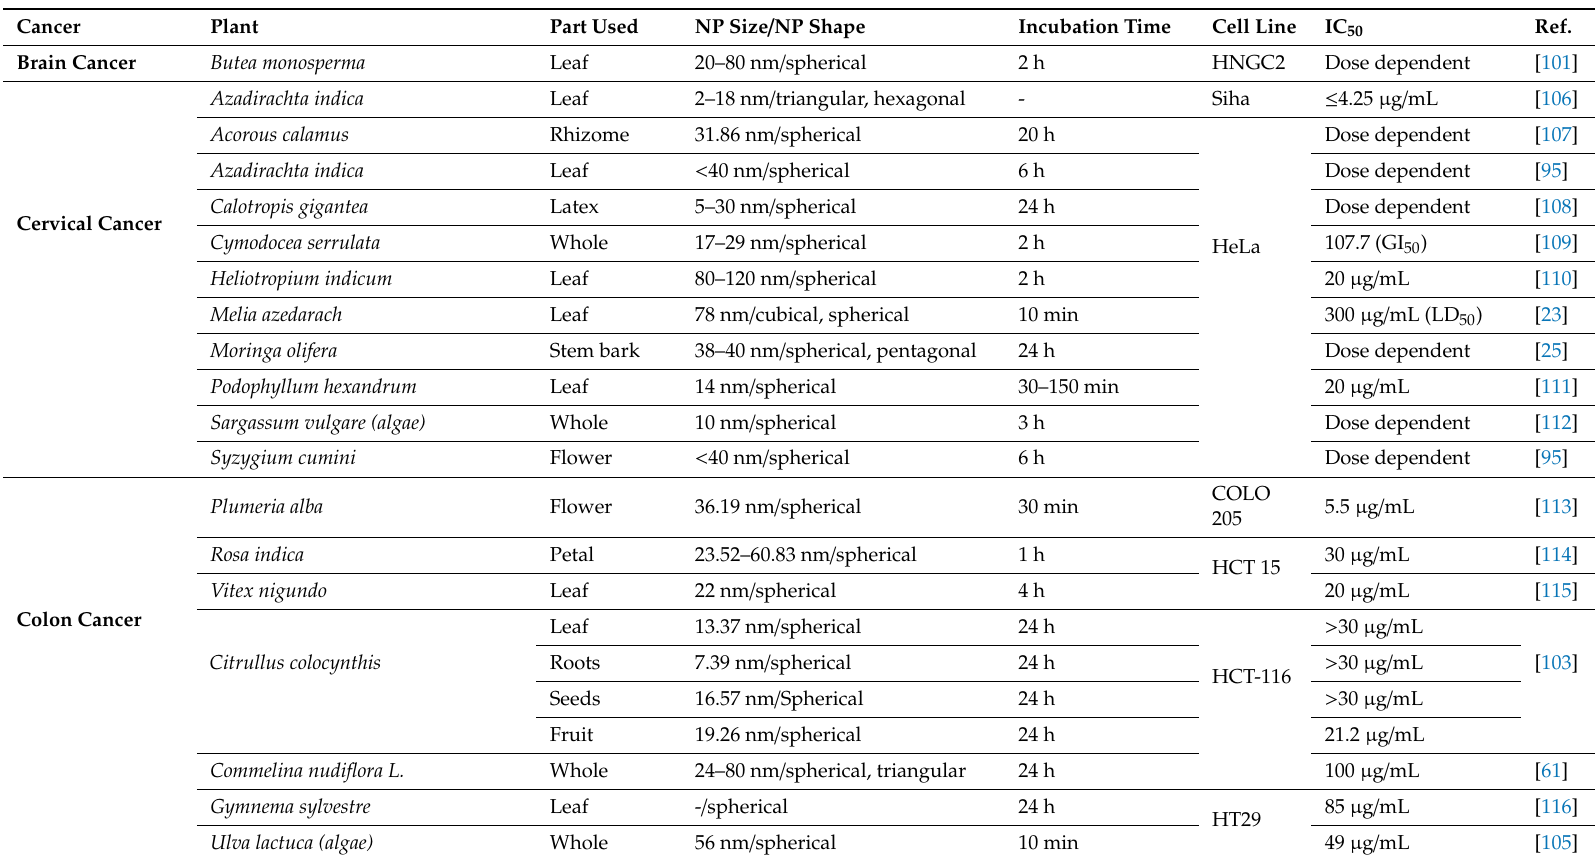
Table 3. Studies of plant extracts for the biosynthesis of anticancer AgNPs (brain, cervical and colon cancers cell